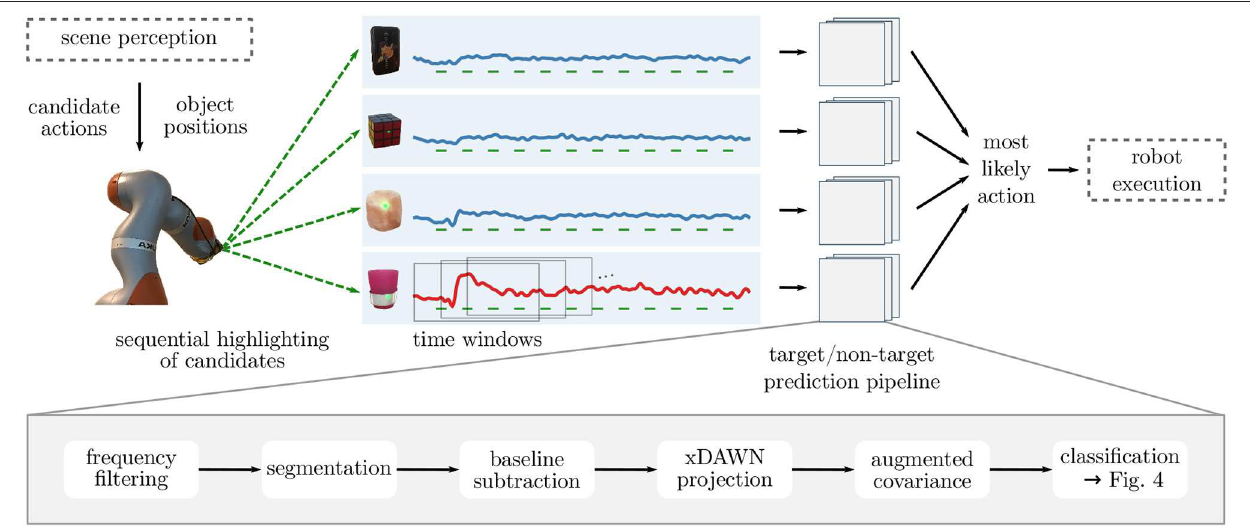
FIGURE 3 | Overall architecture of the screen-free BCI: In order to identify user intentions, candidate objects—corresponding to possible actions of the robot—are highlighted sequentially. Time windows aligned to each stimulus are preprocessed and their covariance representation is used for classification (see lower part of the figure and Figure 4 ). Based on the predicted probabilities that the user attended the object in a given time window (i.e., whether it was the target), the most likely candidate is identified and the appropriate action is taken. In a future application setting, we see this pipeline combined with scene perception and object manipulation (marked by dashed boxes). In this work, however, we fixed candidate objects and gave purely visual feedback on the decoded target object rather than executing a grasp.